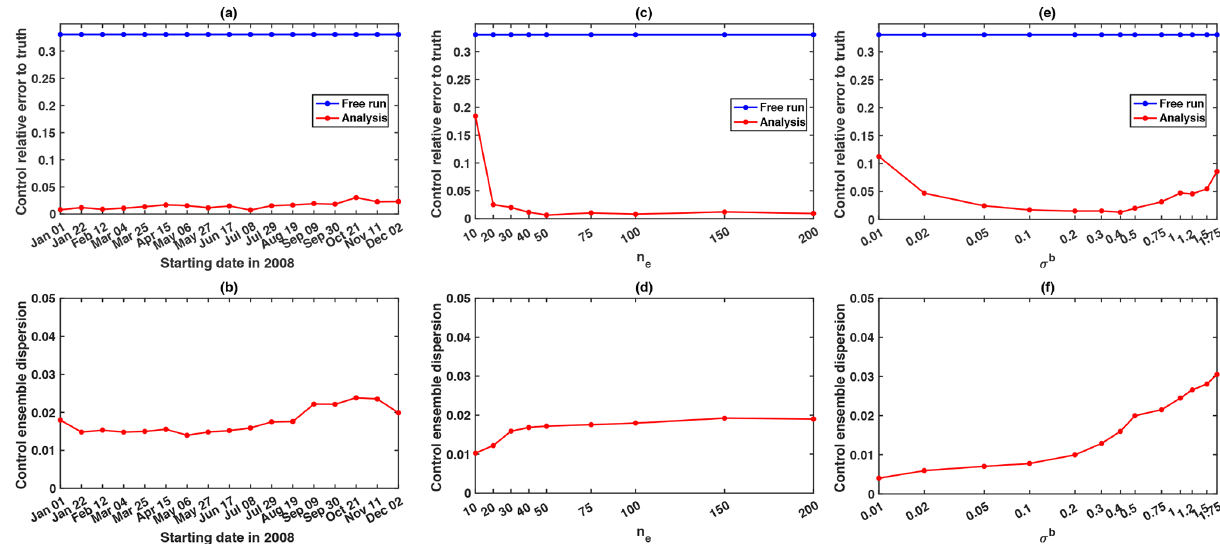
Figure 6. Top: relative error (to the truth) and (bottom) dispersion of the analysis control ensemble (averaged over all control variables) for the sensitivity tests to (a, b) the data assimilation starting date, (c, d) the ensemble size n e , and (e, f) the background error standard deviation σ b . For each test, a set of one-cycle long data assimilation experiments is